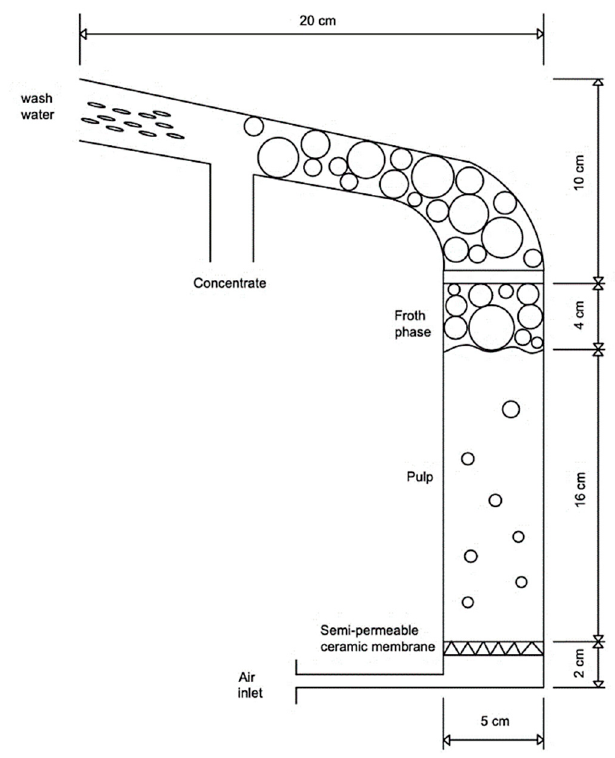
Figure 3. Hallimond tube adapted as pneumatic cell flotation equipment.